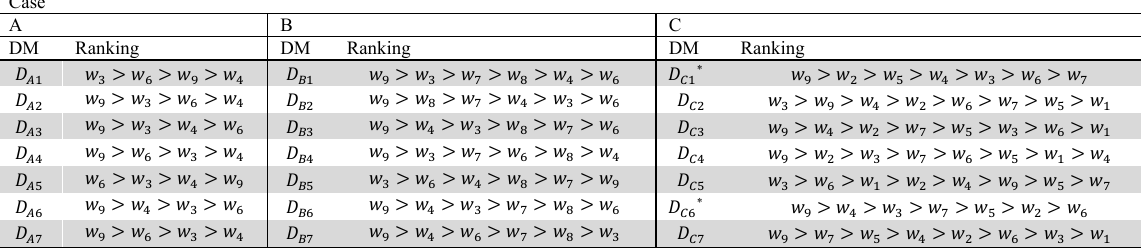
Rankings of criteria weights for all cases and DMs.